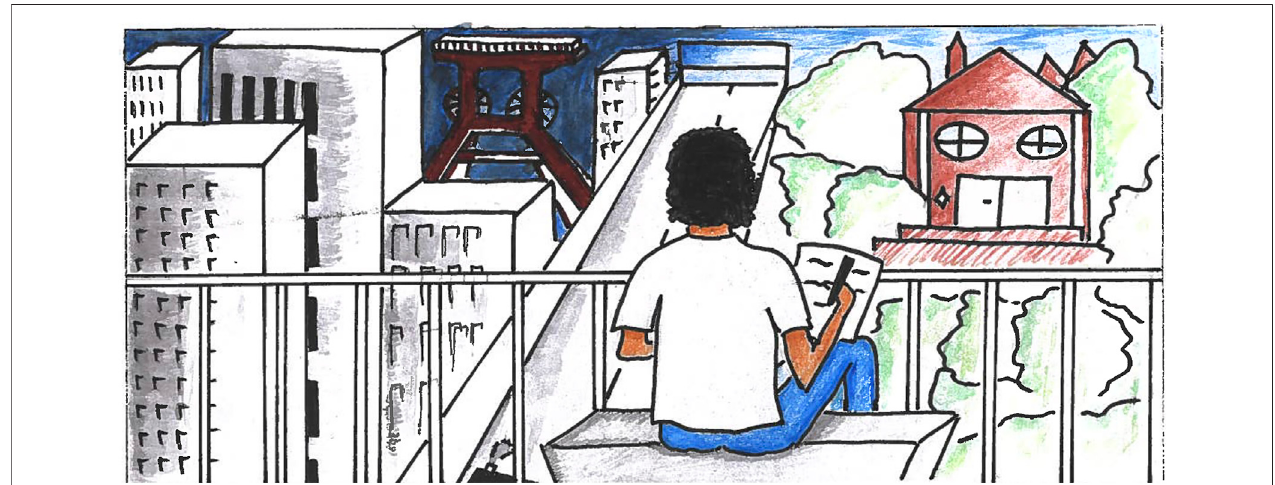
FIGURE 8 | Depicting the social construction of space and questioning it by adding a personal view on it. Image courtesy of J. Becker.